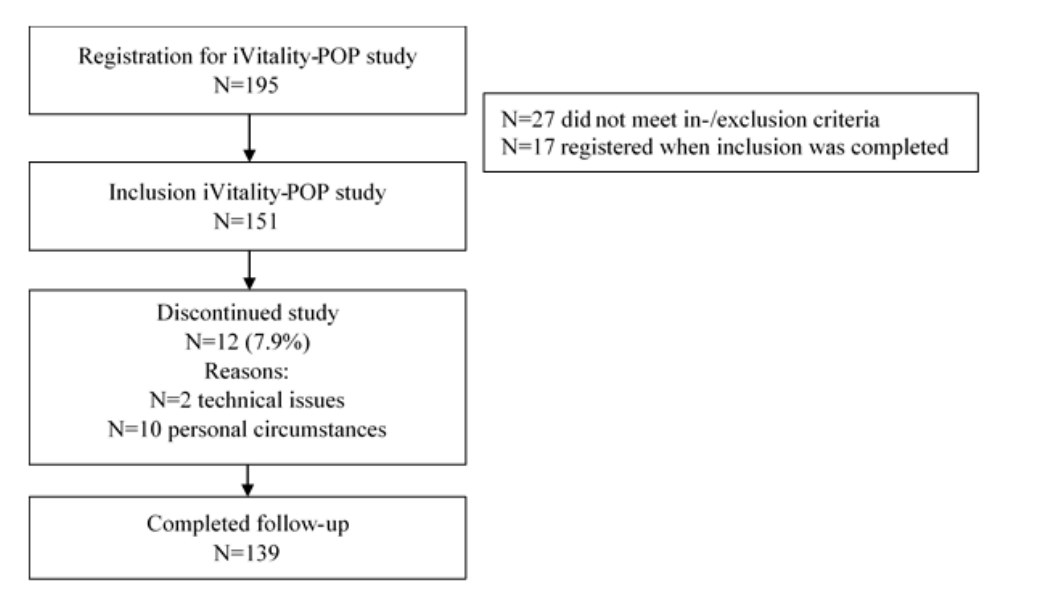
Figure 1. Flowchart inclusion of study participants.